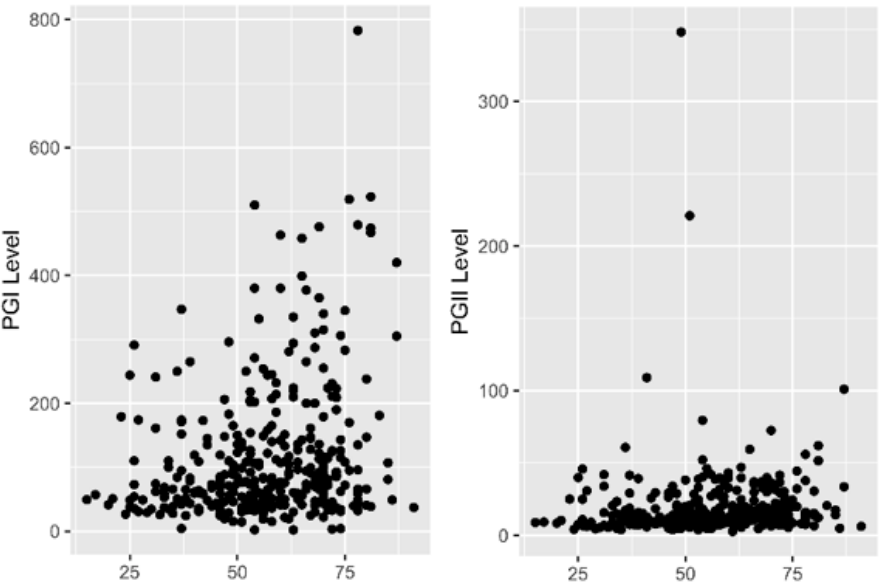
Figure 3. Correlation of pepsinogen (PG) with age. X -axis represents the age and Y -axis represents levels. PGI level and PGI/PGII ratio were weakly correlated with age. PGII was not significantly correlated with age.